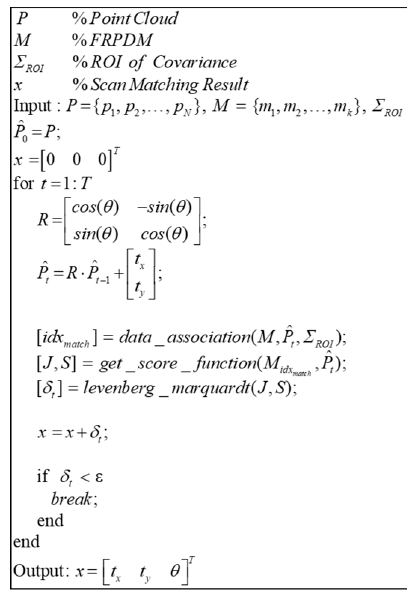
Figure 21. Pseudocode of point-to-probability distribution scan matching.